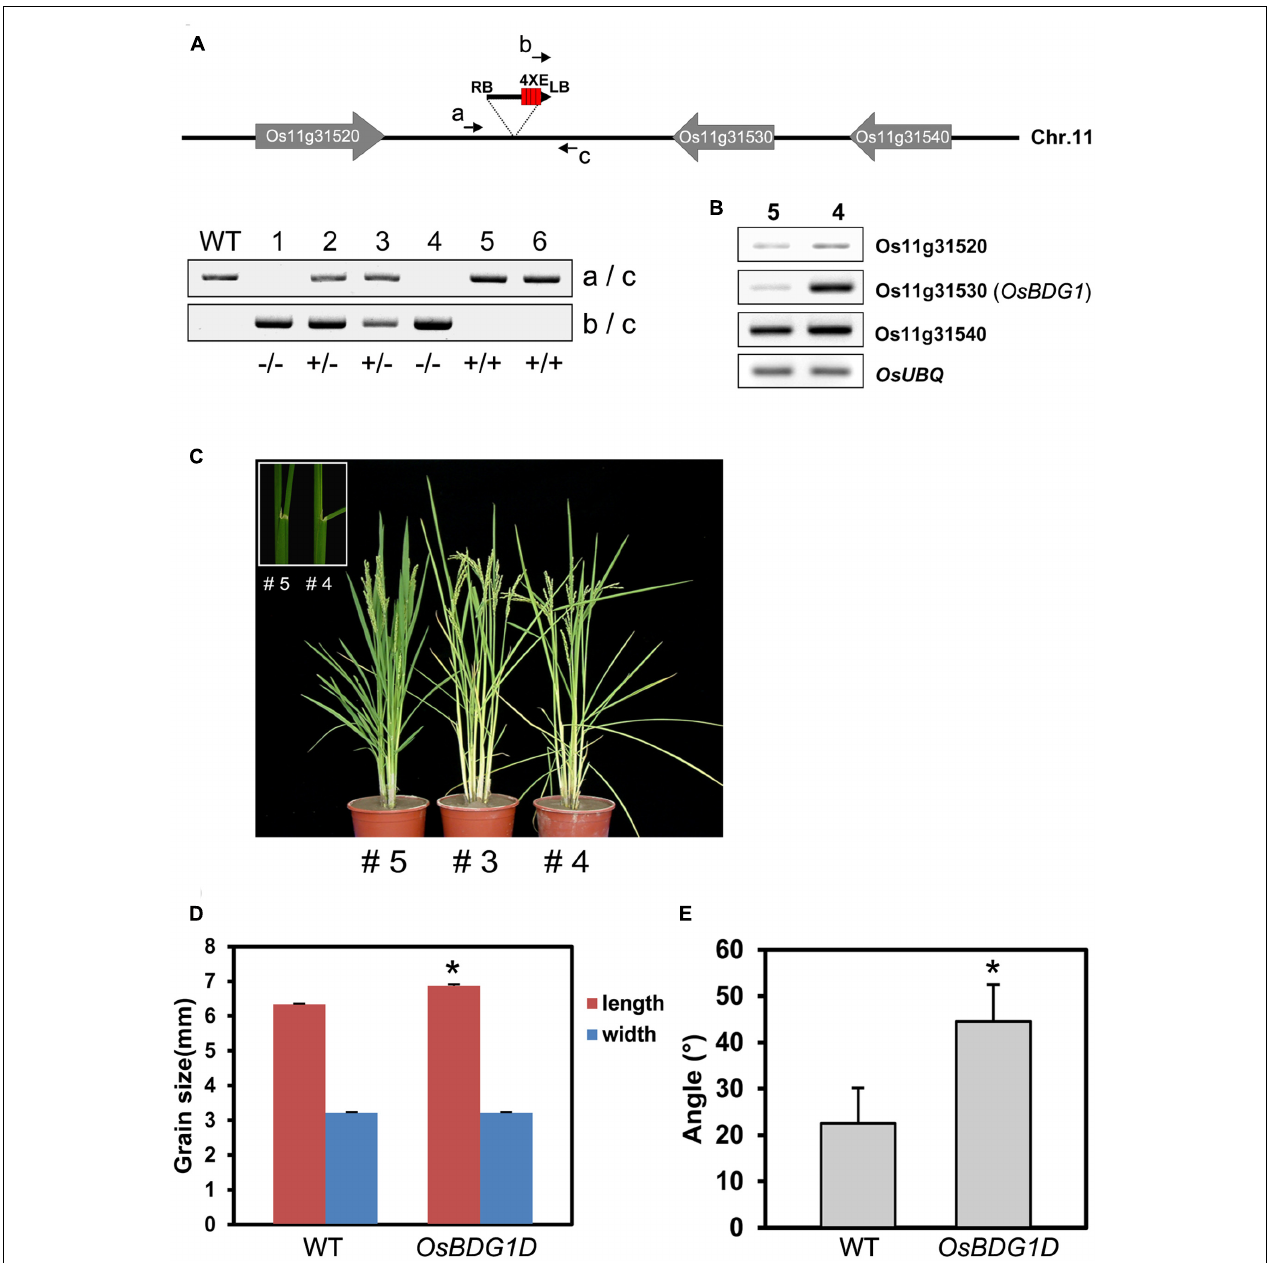
FIGURE 3 | Identification and characterization of an OsBDG1 activation tagging line. (A) T-DNA is inserted in the intergenic region between Os11g31520 and Os11g31530. Genotyping was conducted by primers, (a) 5 (cid:48) CATAGGAACAGAAGGAGTAC 3 (cid:48) , (b) 5 (cid:48) GACGAGAGTGTCGTGCTCCACCATG 3 (cid:48) and (c) 5 (cid:48) GAGGAGATTGTGGGCTCATG 3 (cid:48) . (B) Expression of genes located near the T-DNA insertion. (C) A gain-of-function line of OsBDG1 showed increased lamina inclination. Lamina joint area of a WT segregant (#5; left) and a homozygous OsBDG1D line (#4) is shown in the box. (D) OsBDG1D plants produced grains with increased size and (E) caused increased leaf angles (the third leaf from the top of main stems). Error bars indicate SD. ( ∗ P < 0.01, Student’s t